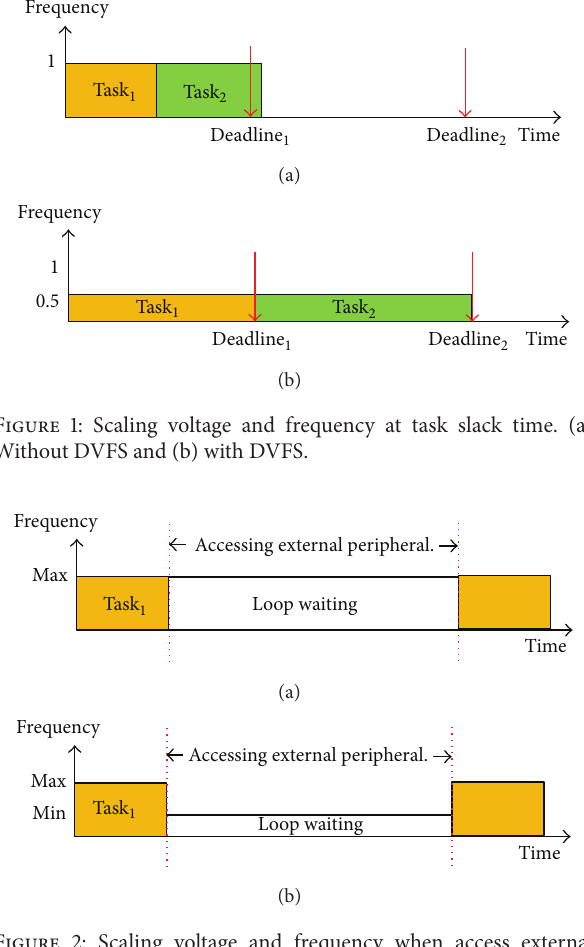
Figure 2: Scaling voltage and frequency when access external peripheral. (a) Without DVFS and (b) with